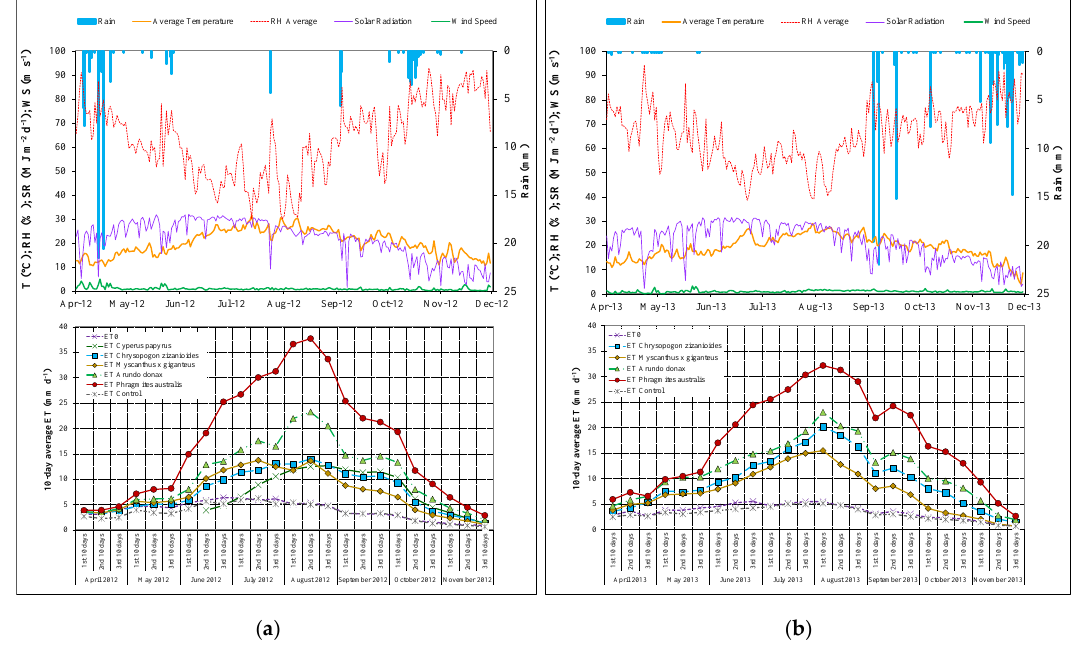
Figure 6. Trend of meteorological data and 10-day average ET 0 , ET con , and ET for C. papyrus , C. zizanioides , M. giganteus , A. donax , and P. australis during 2012 ( a ) and 2013 ( b ) observation